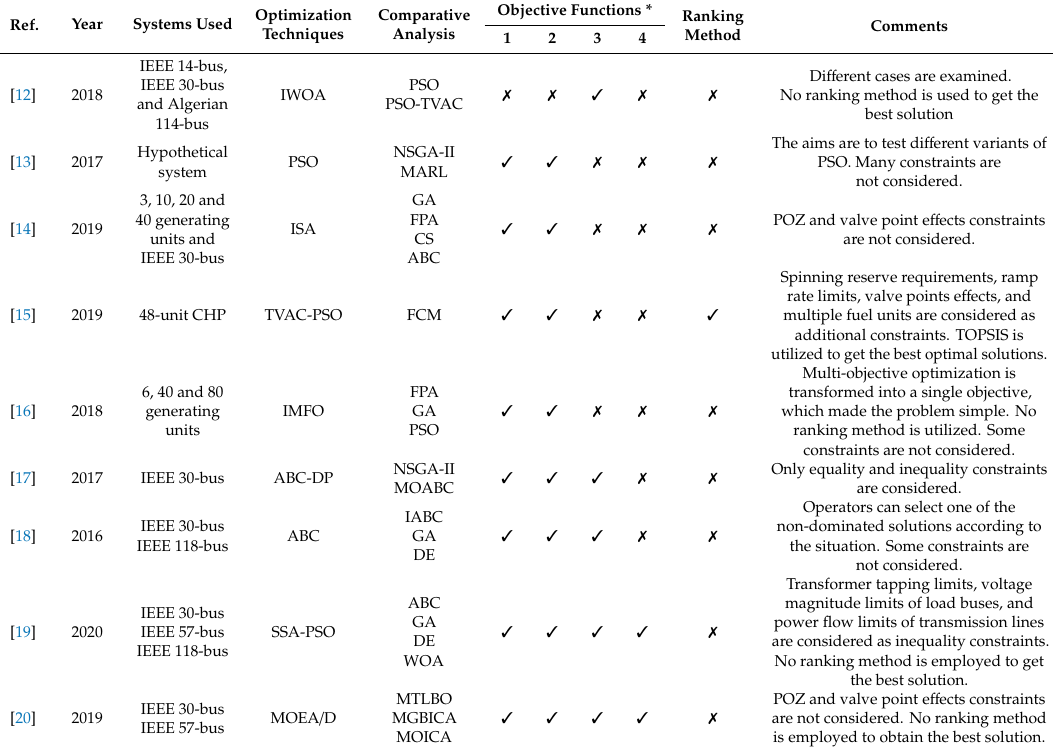
Objective Functions *